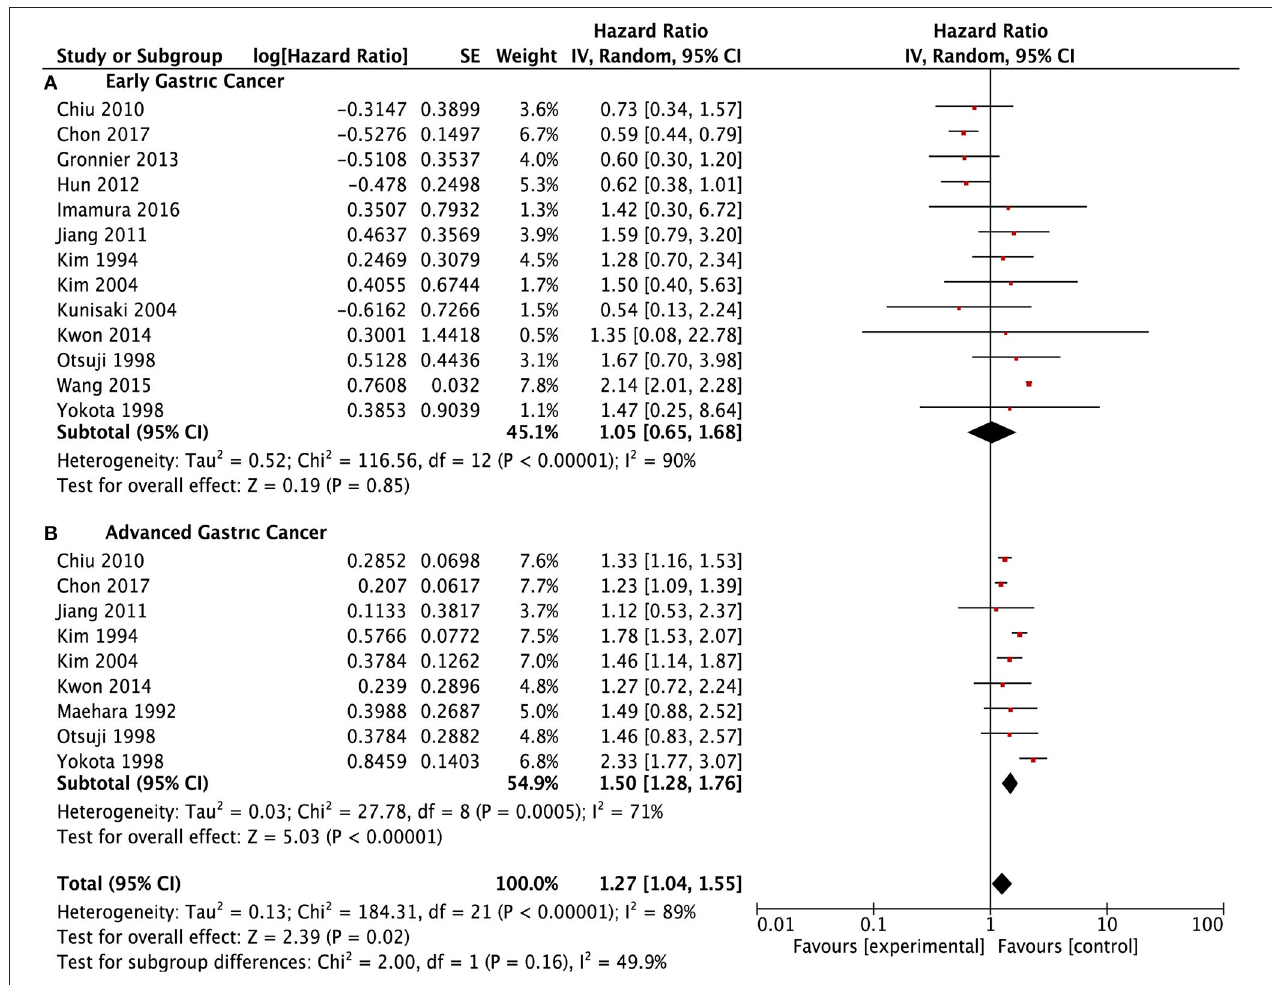
FIGURE 3 | Forest plots showing the survival outcomes of meta-analysis comparing the early gastric cancers and advanced gastric cancers between SRCC and NSRCC patients. (A) Early gastric cancer. (B) Advanced gastric cancer.